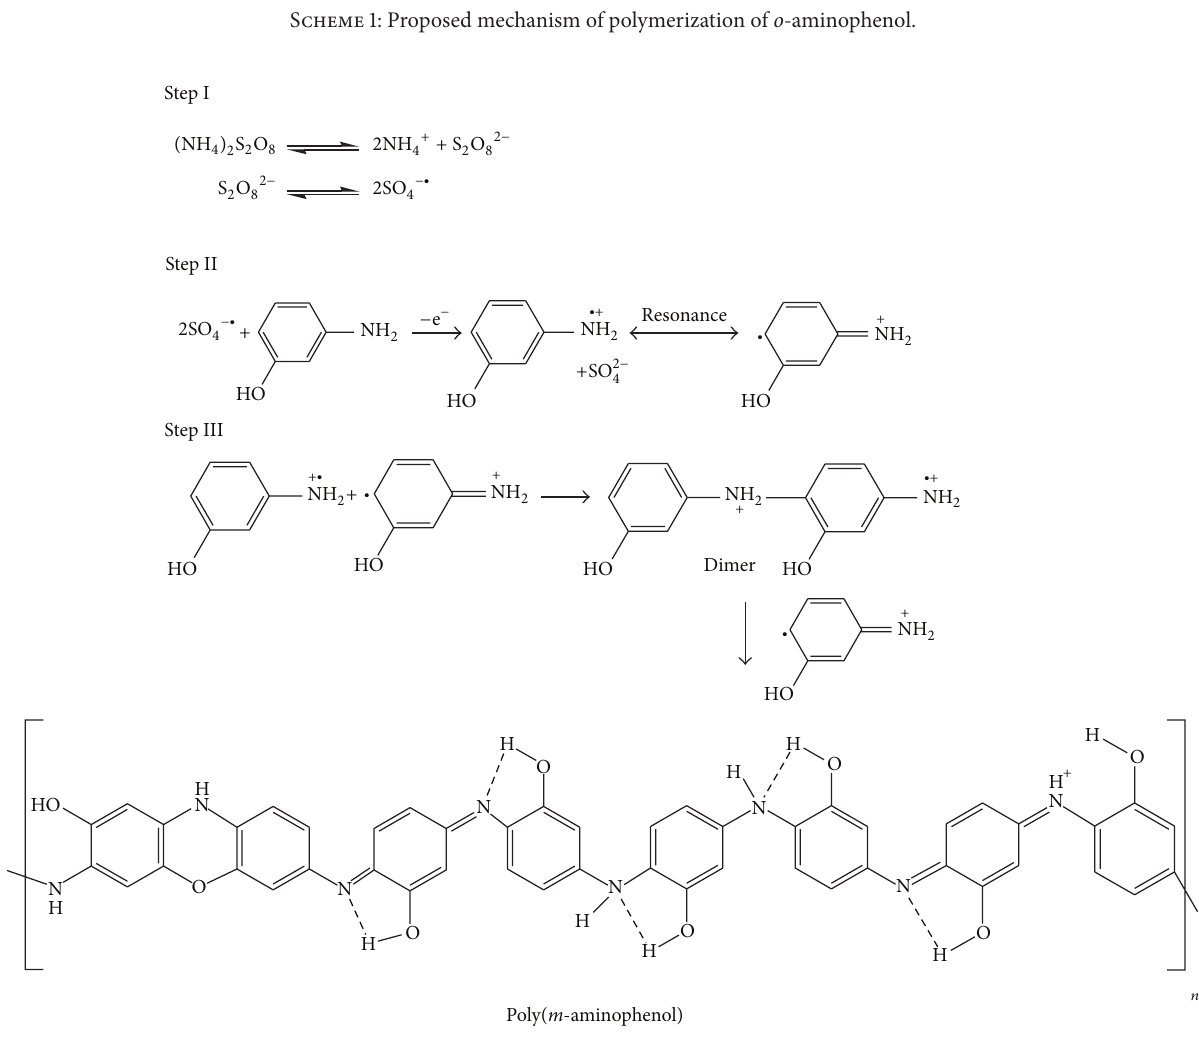
Scheme 2: Proposed mechanism of polymerization of m